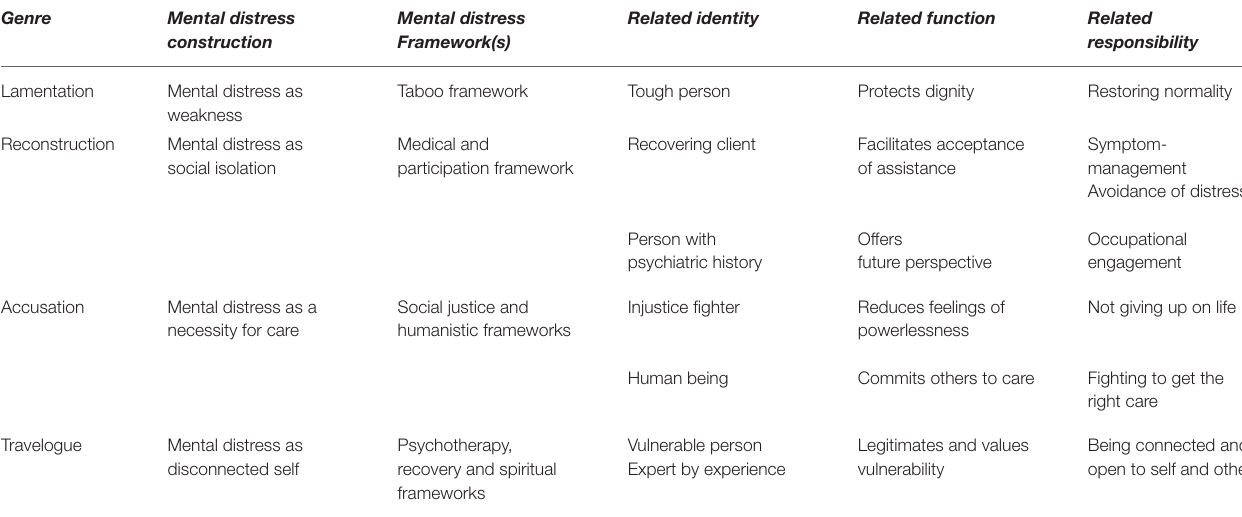
TABLE 5 | Synthesis of results on the ideological